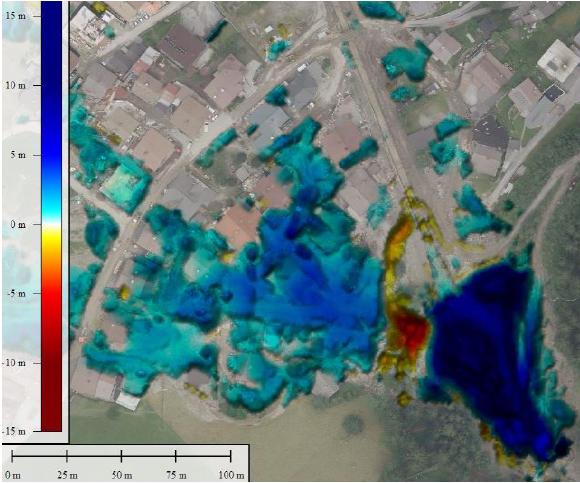
Figure 10. Ortho photo detail overlaid by terrain changes in the village part close to the flood detention basin. Figure 11 shows a zoom in the upper part of the torrent, where break-lines and uprooted trees are clearly visible. Our results were very well in line with expert estimations of the magnitude of the mudslide.